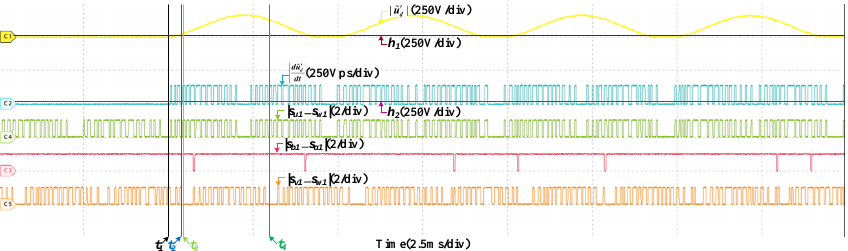
Figure 15. HIL results when the offset fault occurs in S Cu at 300 km/h.